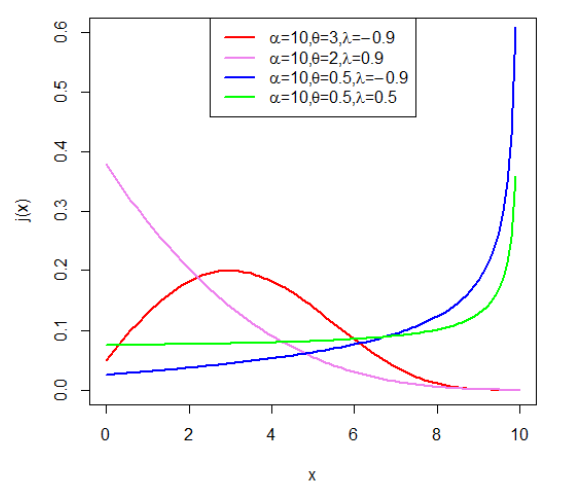
Figure 2 – Pdf of ET U distribution for various choices of α , θ and λ .